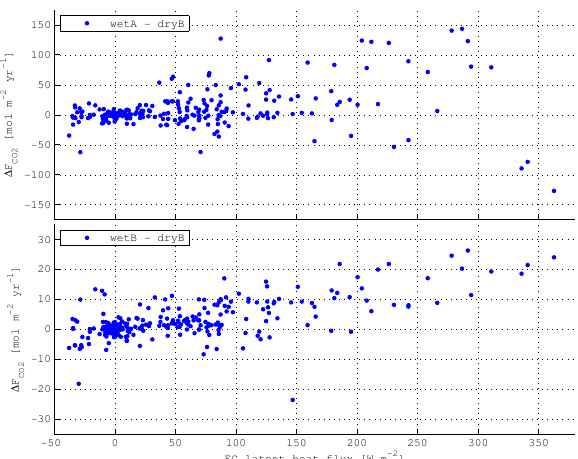
Fig. 7. Scatter plot of the CO 2 flux measurements from wetA against those from dryB before (left) and after the PKT correction was ap- plied to the wetA measurements (right). Bin averages of 15 bins with an equal number of data points are shown as black circles, with error bars indicating the standard deviation from the bin average. A lin- ear regression to the data is shown as a solid black line, and the 1 : 1 agreement is indicated with a grey dashed line. Only intervals for which the PKT correction provided a result for both wetA and wetB were used for this